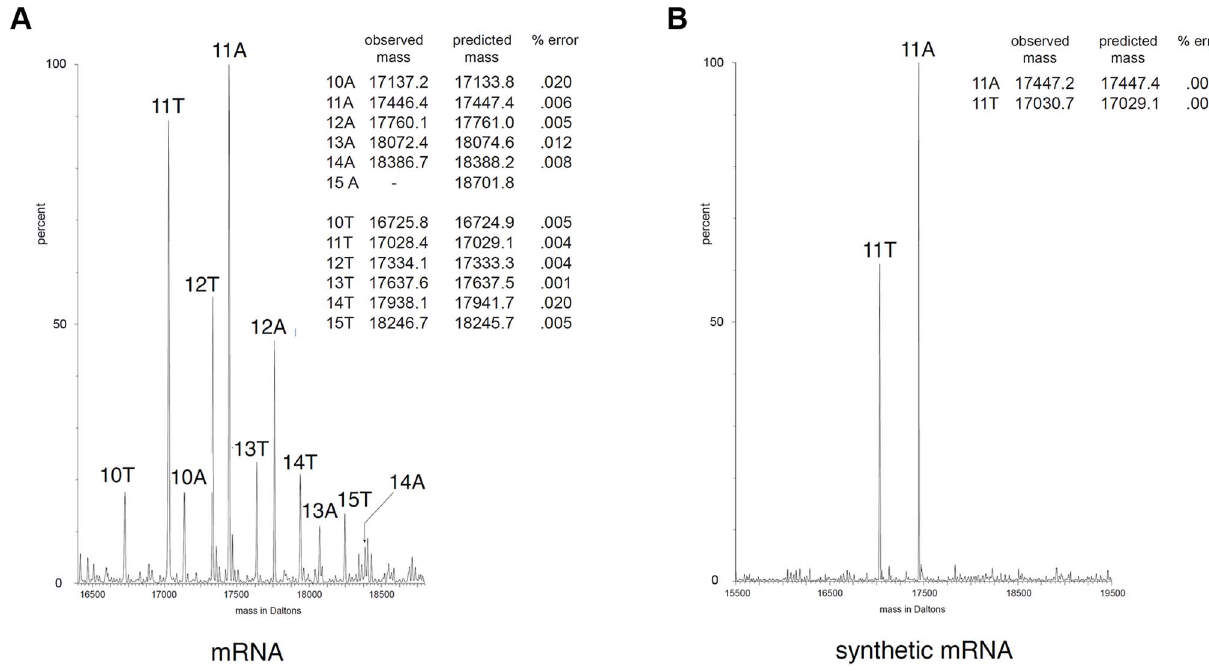
Figure 3. Frameshifting is caused by transcriptional slippage. ESI/MS analyses. Mass spectra of PCR products encompassing the tssM1 poly-A tract generated by RT-PCR from C. rodentium total RNA (mRNA; A) or from a synthetic mRNA (B). The two strands of the PCR products are observable. The molecular mass (in Da) is shown on the x axis, and the relative intensity of the signal is indicated on the y axis. The number of A or T residues in the homopolymeric run is shown above each peak. The measured and predicted masses (in Da) of each peak are shown in the insert for each panel. The difference between predicted and measured masses is expressed as the percentage error for each peak.